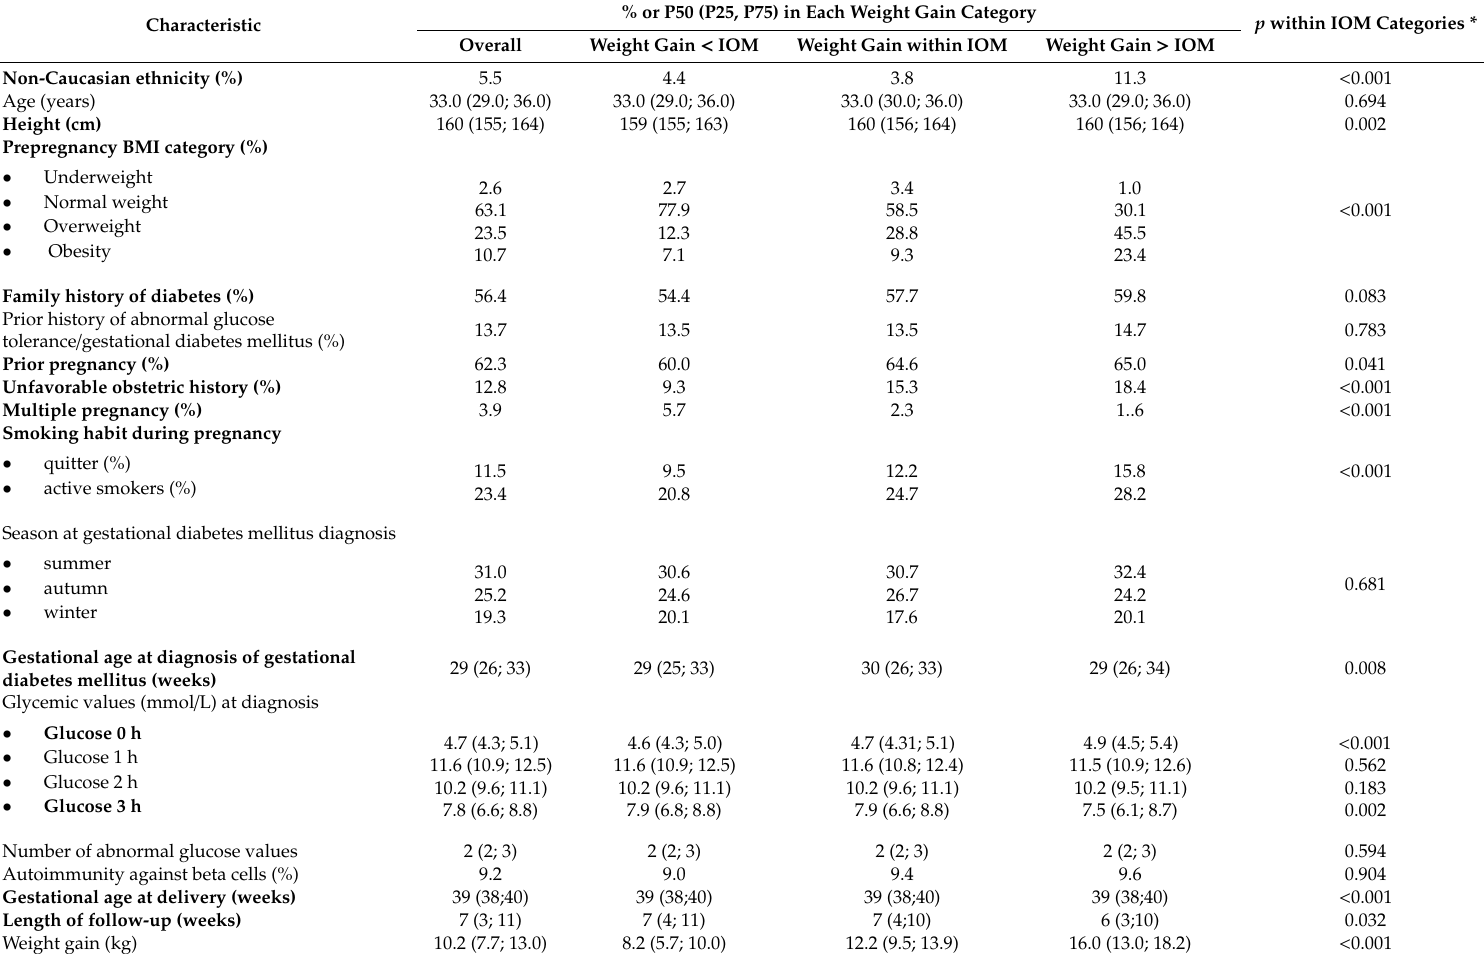
p within IOM Categories *